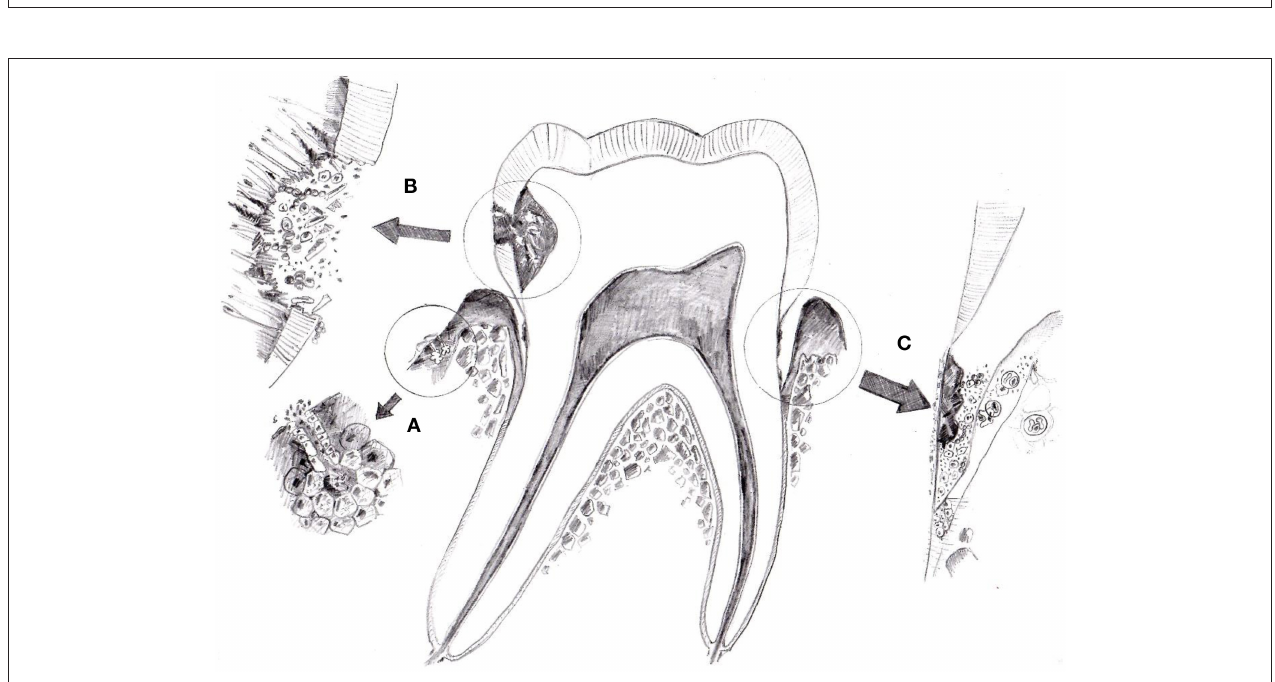
FIGURE 2 | The origin of salivary markers of oxidative stress. Three possible sources are shown—blood plasma (A) , oral bacteria (B) , and immune cells (C) . Although direct evidence is lacking, salivary markers of oxidative stress seem to be of local oral origin. At least in periodontitis the production of reactive oxygen species by oral bacteria or activated neutrophils seems to be of importance. In systemic diseases diffusion from plasma could be the main source of salivary markers of oxidative stress.